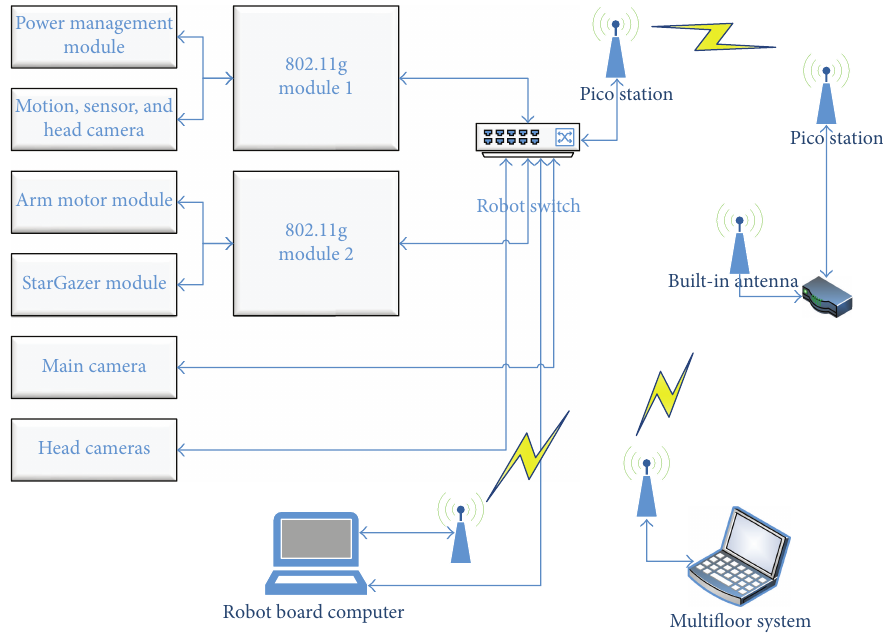
Figure 8: Communication